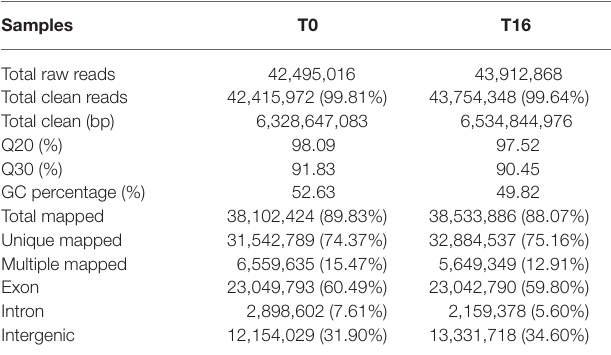
TABLE 4 | Statistic of transcriptome sequencing in L. vannamei